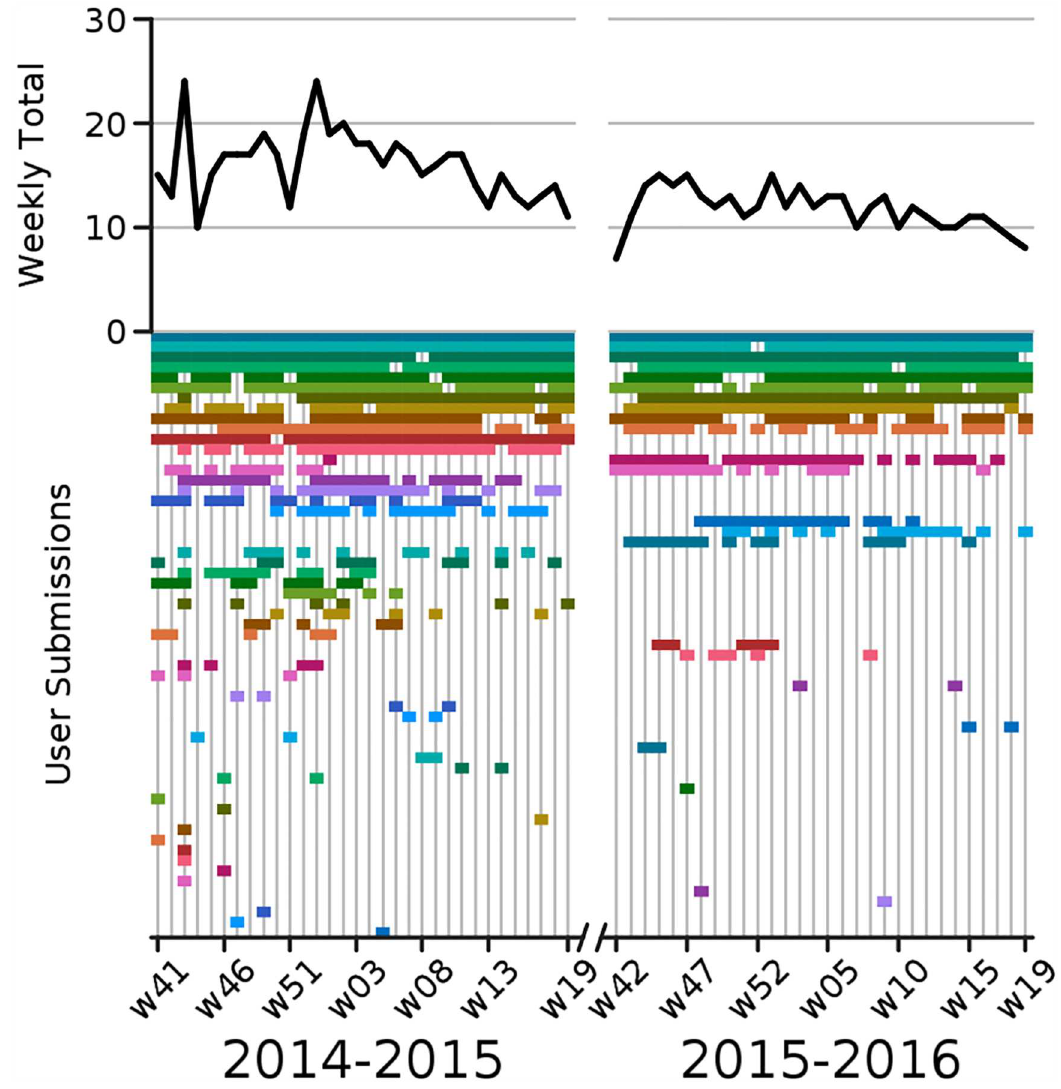
Fig 2. Overviewof Epicast participation. Top: time series of the number of active participants per week. Bottom: timelineof weekly participation. (Assigned colors are for visualizationpurposes only and are consistent across figures.).